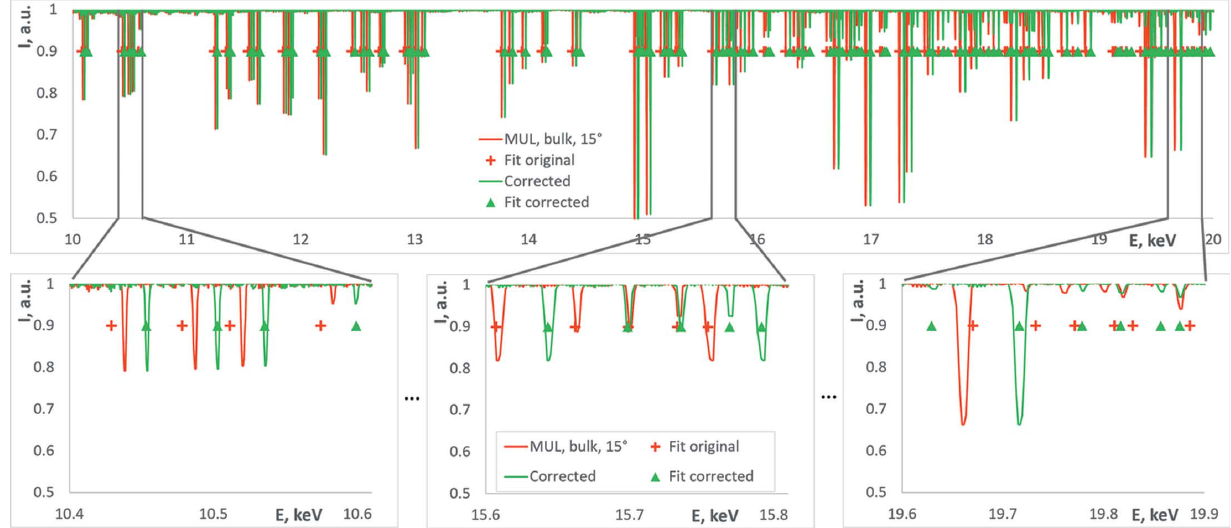
Figure 6 The glitch spectra before (red) and after (green) the energy recalibration (top plot). The green triangles and red crosses represent the simulated glitches for the two spectra. To see the details, small parts of the spectrum are presented over the whole measured range (10–20 keV) on the bottom